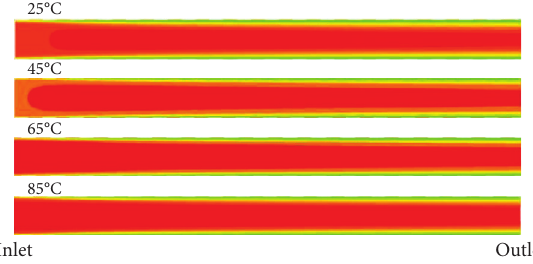
Figure 9: Vectors of velocity at radial section at 25 ° C–85 ° C